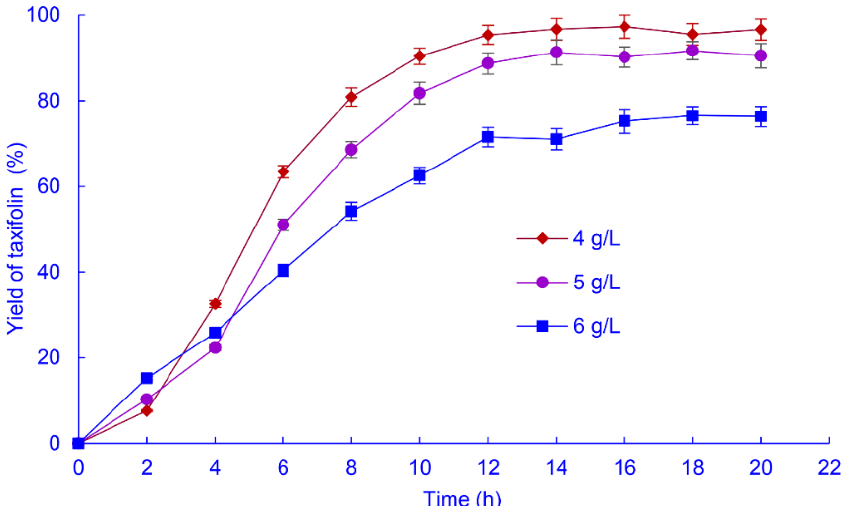
Figure 6. Time course of the yield of taxifolin from biotransformation of astilbin at different concen- trations by A. fumigatus SQH4. Biotransformation was performed at 35 °C, pH 6.5, with shaking at 200 r/min.